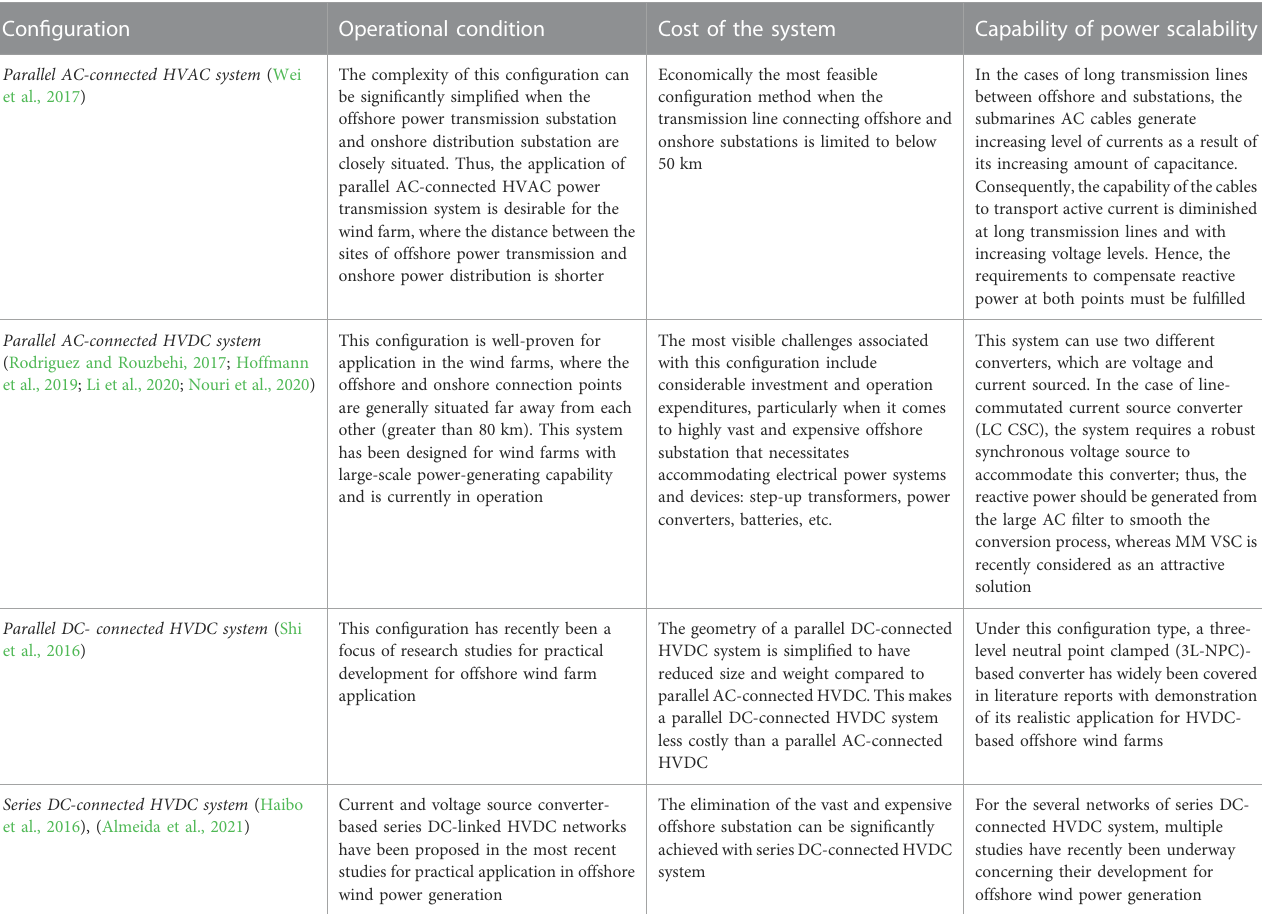
TABLE 3 Comparison of different con fi gurations of HVAC and HVDC converter systems. Con fi